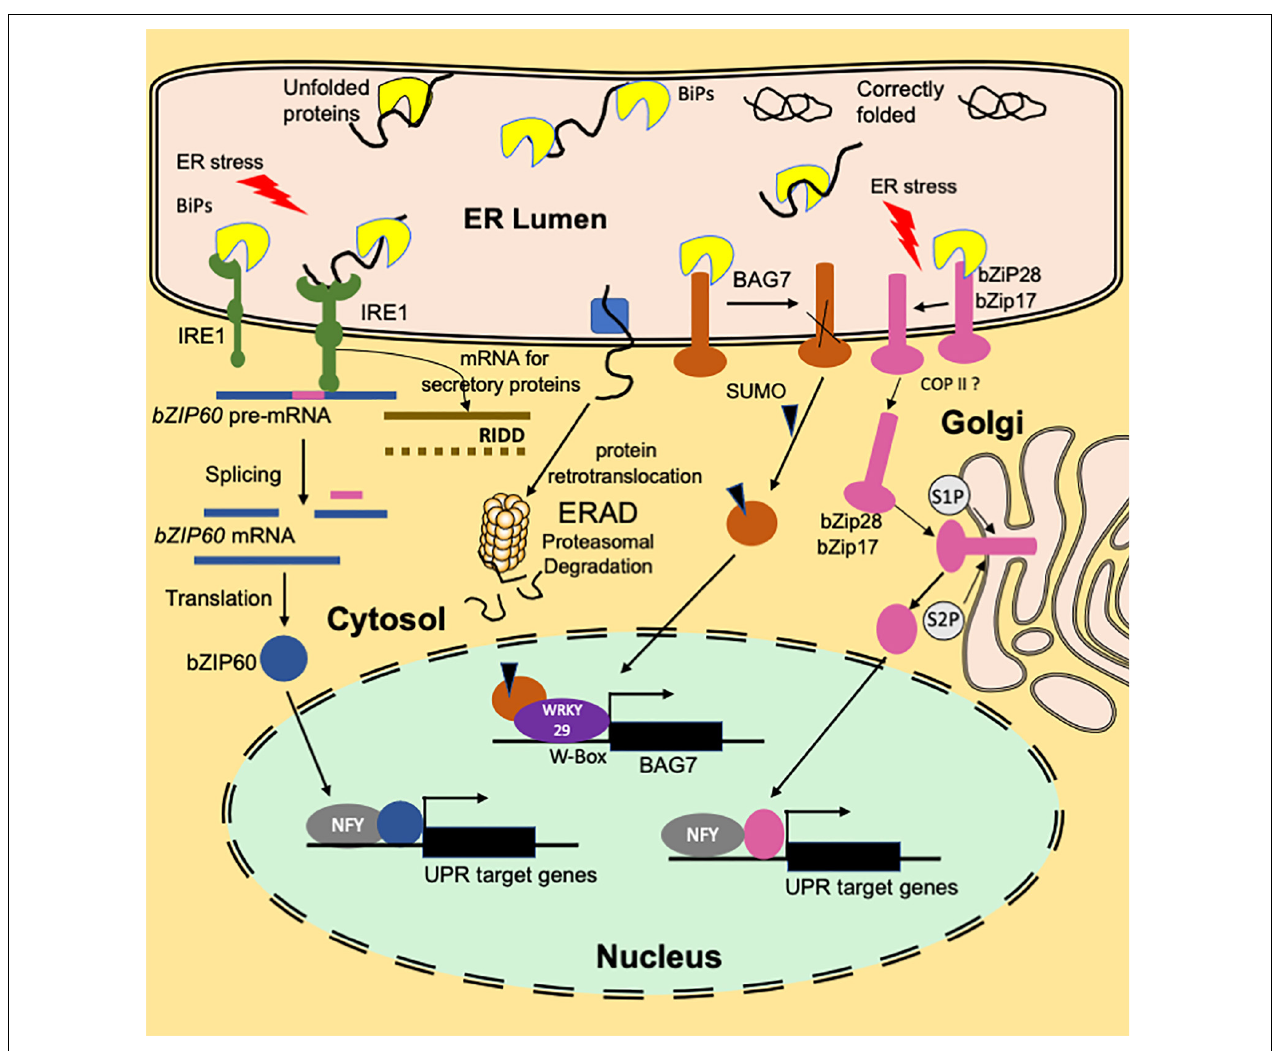
FIGURE 1 | An overview of the functioning of plant ER stress signaling in response to heat stress. A branch of the UPR signaling pathway involves ER transmembrane sensor, IRE1, that propagates the UPR signal from ER to the cytosol. Association with luminal BIP keeps IRE1 in an inactive monomer form. Under ER stress conditions, BIP dissociates from the sensor end of IRE1 to facilitate the folding of the accumulated unfolded proteins. The binding of unfolded proteins to the luminal domain of IRE1 triggers dimerization (or oligomerization) and activation of RNase activity that cleaves bZIP60(u) mRNA resulting in a spliced variant bZIP60(s). Translation of the spliced variant leads to the synthesis of active bZIP60 TF protein whose transport to nucleus activates the stress-responsive genes. Another function of IRE1 is IRE1-Dependent RNA Decay (RIDD) that involves degradation of ribosome-associated RNAs encoding secretory proteins. Dissociation of BIP from ER-anchored transcription factors bZIP28/17 results in their mobilization to Golgi. In the Golgi, these TFs are processed to bZIP17(p) and bZIP28 (p) by S1P and S2P proteases to release cytosolic facing domains that are further transported to the nucleus. In the nucleus, bZIP28/17 bind to ER stress response elements to upregulate the transcription of UPR genes. Another branch of UPR involves an ER-resident transcription factor, BAG7. BAG7 is involved in UPR in response to heat and cold stress conditions by acting as a co-chaperone to prevent the accumulation of unfolded proteins. Under heat stress conditions, BAG7 is sumoylated, released from ER by protease and then translocated to the nucleus where it interacts with WRKY29 to regulate BAG7 and other chaperone expression.